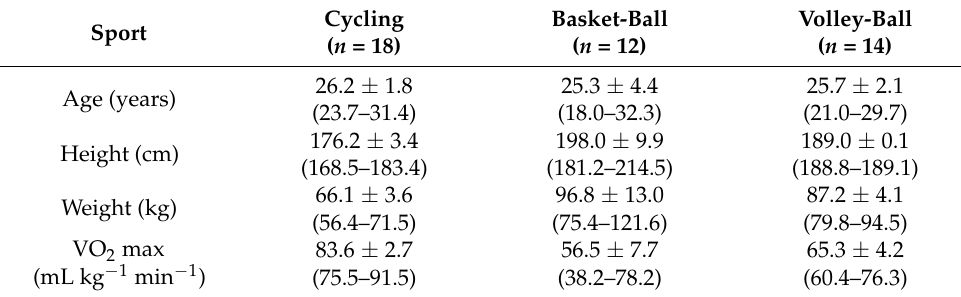
Table 1. Baseline parameters of participants in the